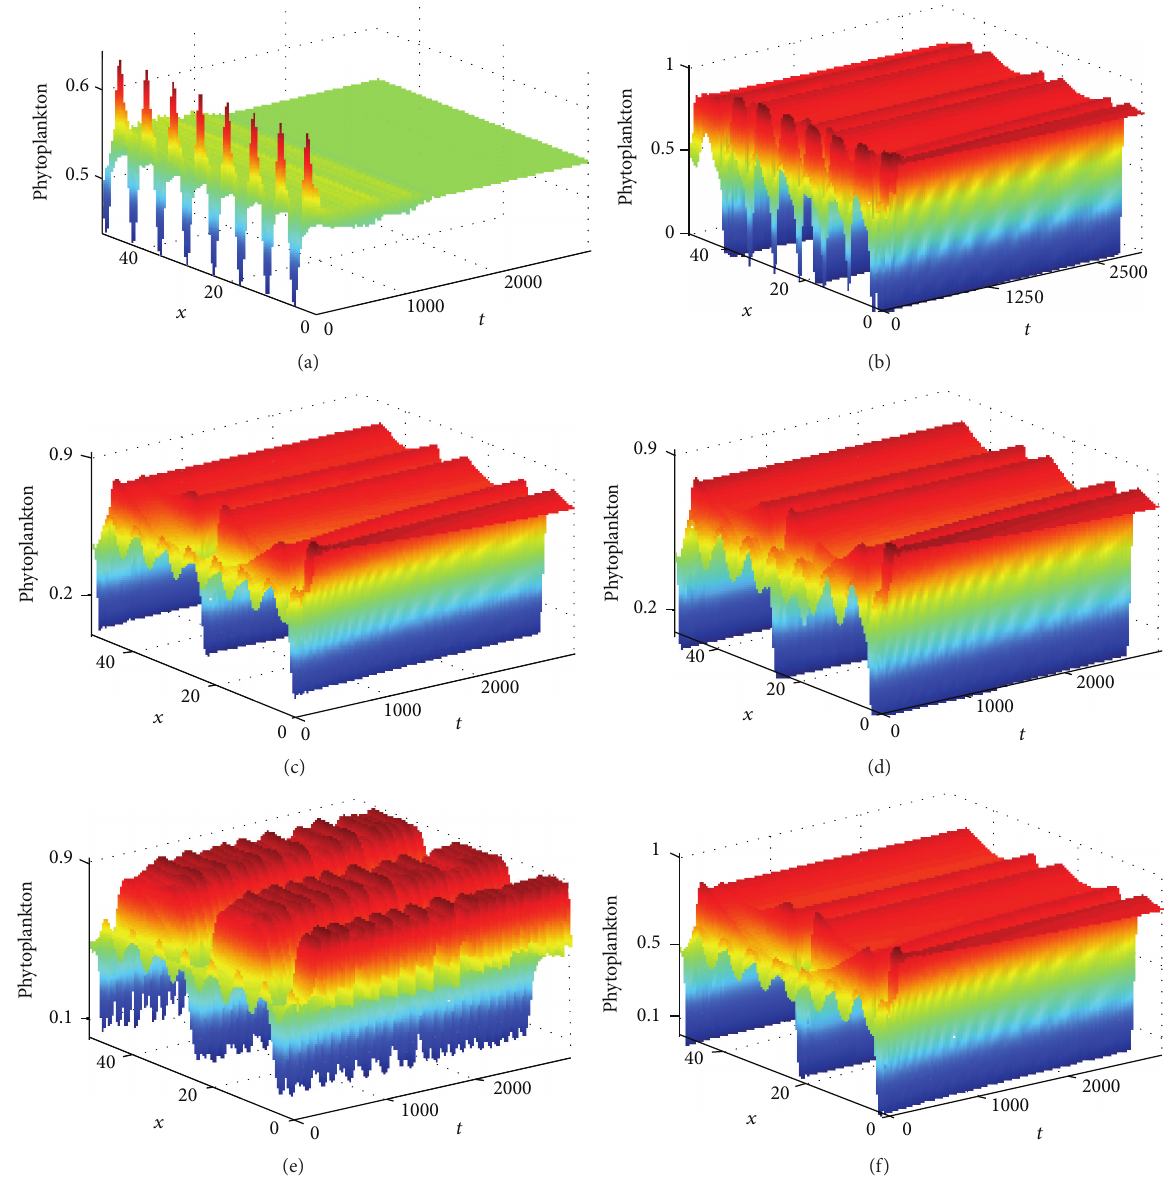
Figure 2: Numerical stability of system (2) with the following parameters: 𝐾 = 0.205 , 𝑢 1 = 0.7 , 𝑟 1 = 0.2 , 𝑢 2 = 0.382 , 𝛽 1 = 0.21 , 𝛽 2 = 0.2428 , = 0.1 , V = 0.09 , V = 0.013 , 𝐷 = 0.04 , and 𝐷 𝛽 3 1 2 11 = 0.5 , 𝐷 = 0.1 ; (e) 𝐷 = 1 , 𝐷 = −0.5 ; (f) 𝐷 𝐷 21 12 21 12